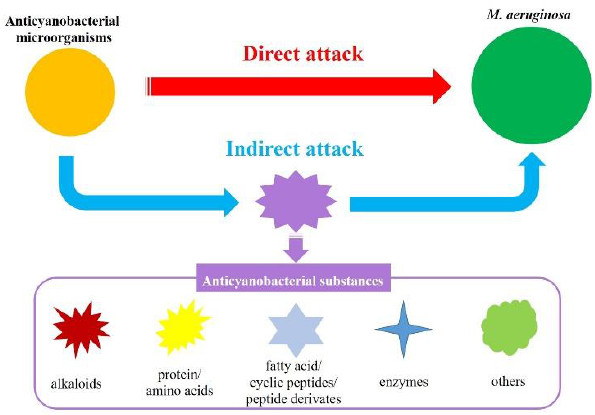
Figure 1 . Anticyanobacterial modes of microorganisms against M. aeruginosa . Figure 1. Anticyanobacterial modes of microorganisms against M. aeruginosa